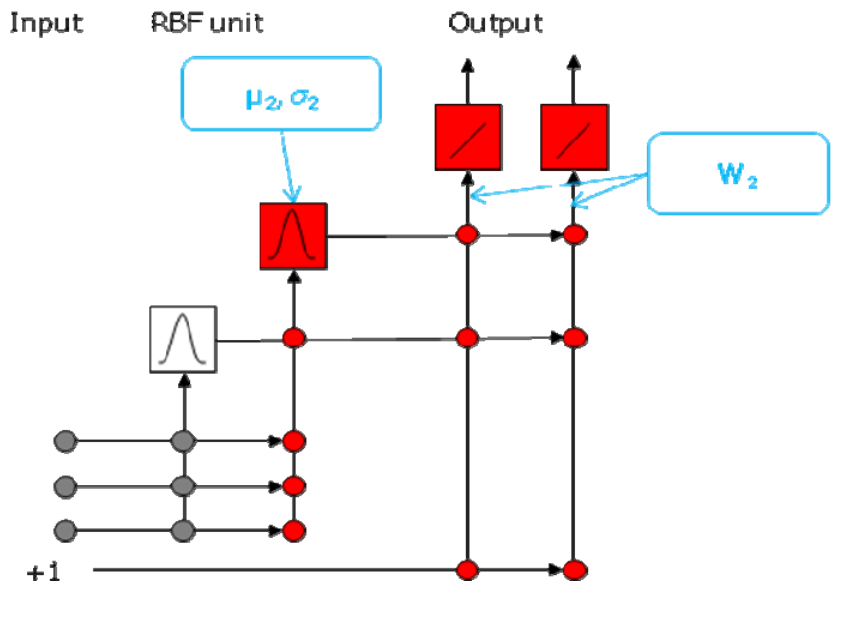
, σ and W are parameters to be 2 2 2